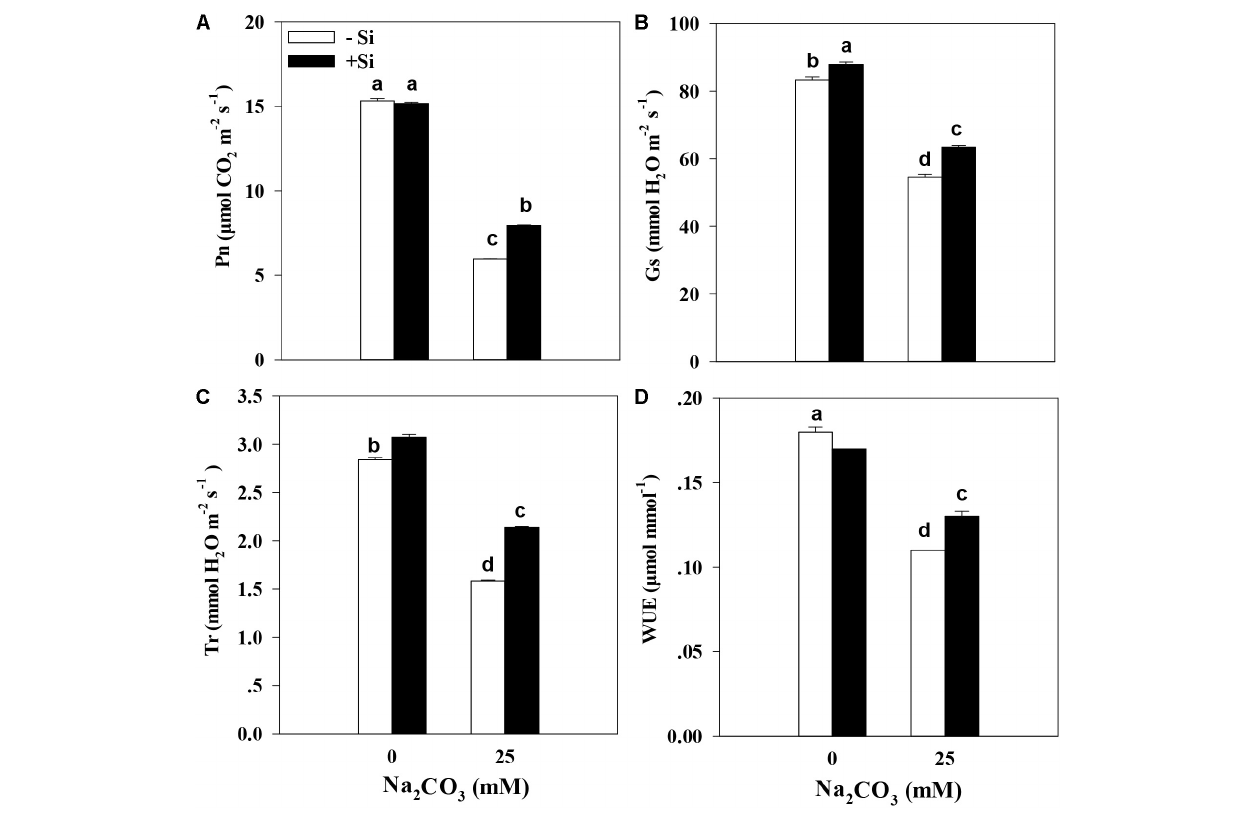
FIGURE 3 | Net photosynthetic rate (Pn) (A) , stomatal conductance (Gs) (B) , transpiration (Tr) (C) , and water use efficiency (WUE) (D) in the leaves of alfalfa seedlings under Si priming in response to alkaline stress. –Si = pretreatment without Si; +Si = pretreatment with Si. Values are means ± SE, n = 25. Different letters denote significant difference ( P < 0.05) based on Duncan’s